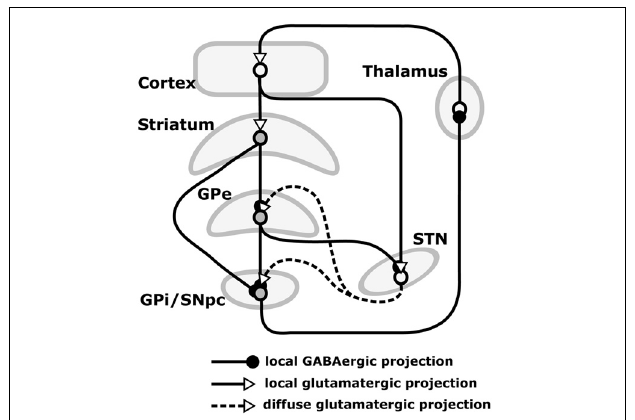
FIGURE 3 | Internal anatomy of a circuit loop through basal ganglia and cortex. GPe: globus-pallidus, external compartment; GPi: globus-pallidus, internal compartment; SNpr: substantia nigra pars reticulata; STN: sub-thalamic nucleus.